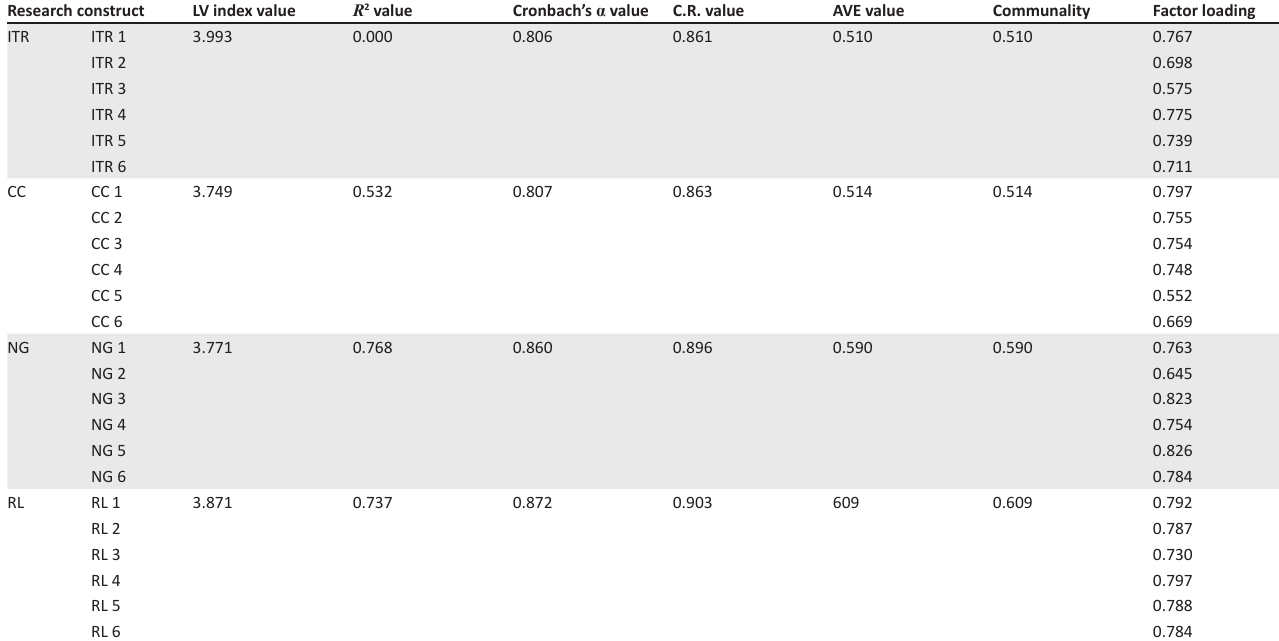
TABLE 2: Accuracy analysis statistics. Research